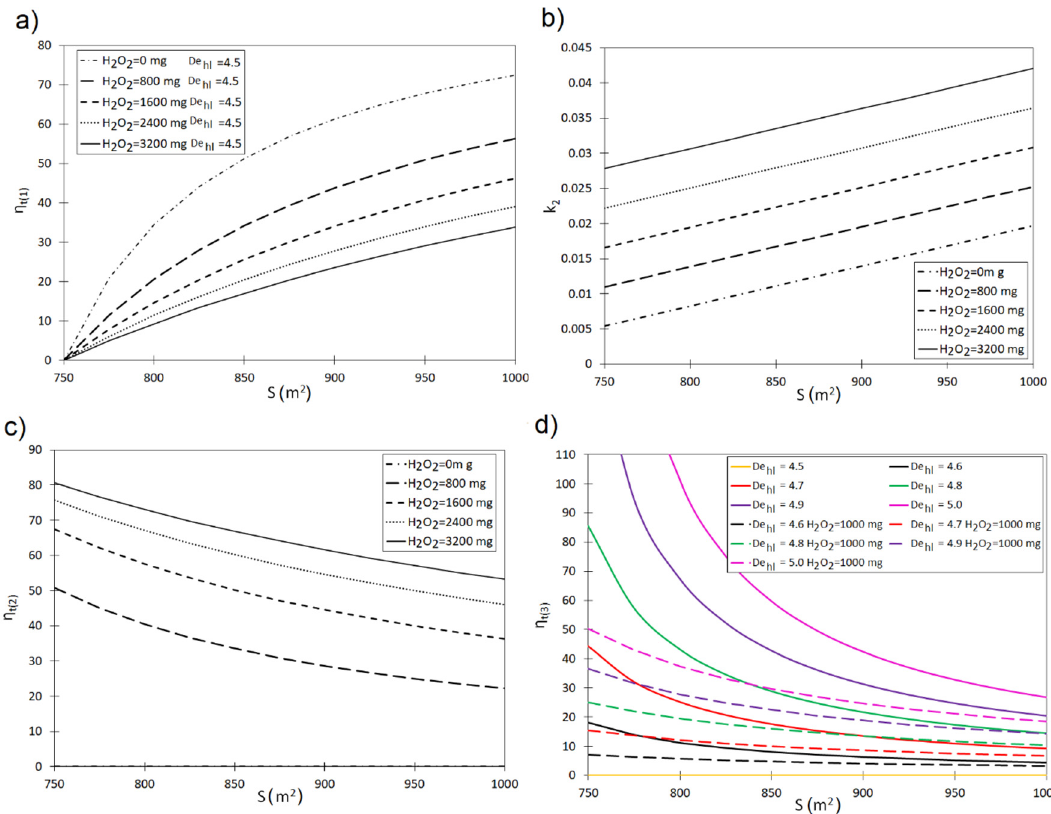
Figure 4. ( a ) Influence of specific surface of activated carbon (S) and oxidizer dose (H 2 O 2 ), for De hl = 4.5 on η (1) . ( b ) Influence of specific surface of activated carbon (S) and oxidizer dose (H 2 O 2 ) for De hl = 4.5 with reaction rate constant k 2 in a pseudo-second order equation. ( c ) Influence of specific surface of activated carbon (S) and oxidizer dose (H 2 O 2 ) for De hl = 4.5 on η (2) . ( d ) Influence of specific surface of activated carbon (S), oxidizer dose (H 2 O 2 ), and dechlorination half-length (De hl ) on η (3)